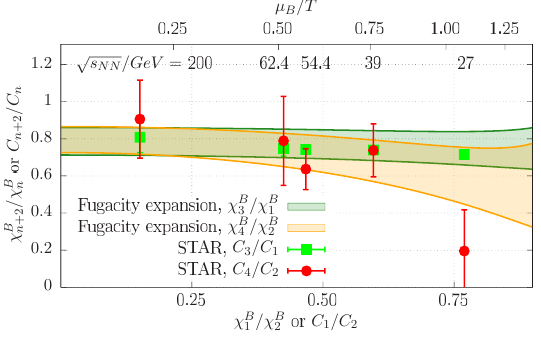
Figure 4. (Ref. [27]) Left: The ratios R B of R B ( T ,µ B ) = M B /σ 2 12 collaboration (Ref. [29, 30]). Right: The ratios R B comparison to the data from the STAR collaboration (Ref. [30]).